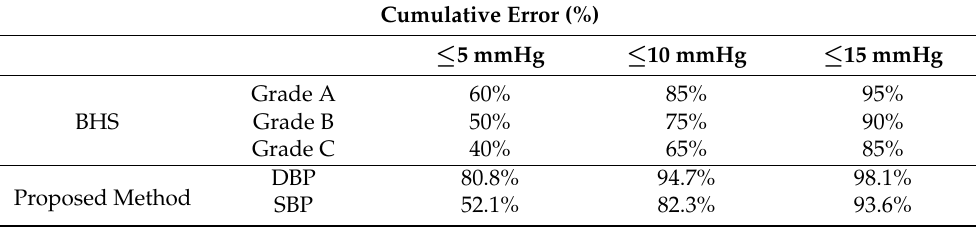
Table 3. Comparison with the BHS protocol.